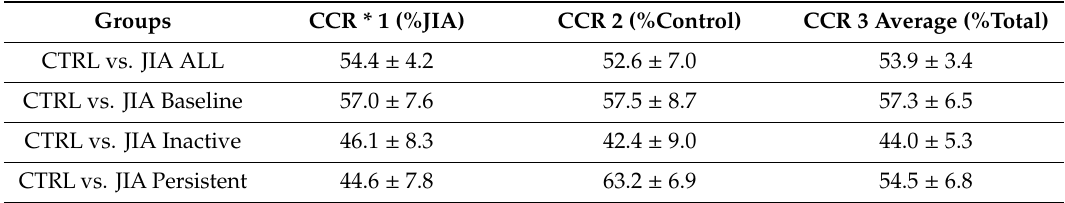
Table 6. PLS-DA models in DCV of Non-VOCs data matrix.